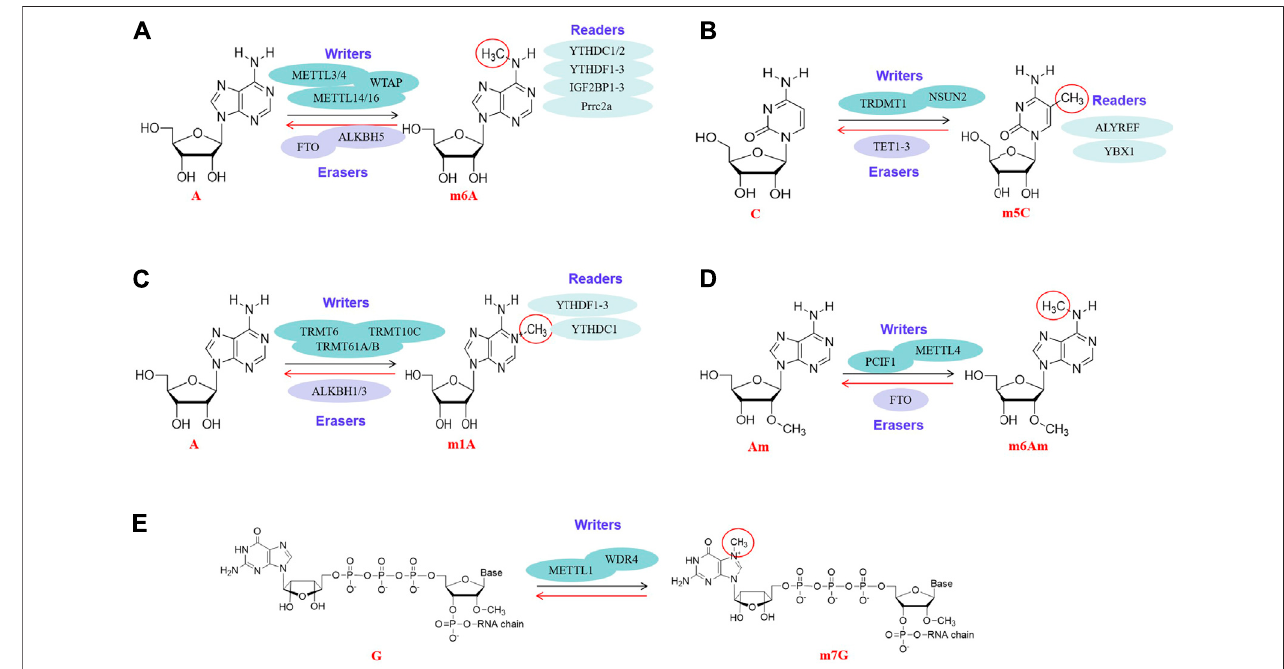
FIGURE 1 | Molecular structures of RNA methylations. All kinds of RNA methylation modi fi cations are mediated by enzymes, including methylases ( “ writers ” ), demethylases ( “ erasers ” ) and methylation recognition enzymes ( “ readers ” ). Methylases and demethylases coordinate the reversible and dynamic changes of RNA methylations, and methylation recognition enzymes are responsible for reading methylation sites and subsequent functions. The RNA methylations involved are m6A ( Figure 2A ), m5C ( Figure 2B ), m1A ( Figure 2C ), m6Am ( Figure 2D ), m7G ( Figure 2E ).